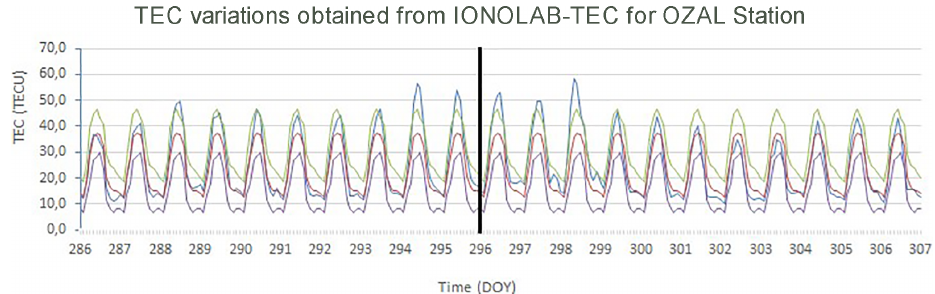
Figure 4. IONOLAB-TEC values for OZAL Station. The purple line shows lower bound TEC values, the bottle green line demonstrates upper bound TEC values, the red line shows mean TEC values and the blue line indicates observed TEC values for every epoch.